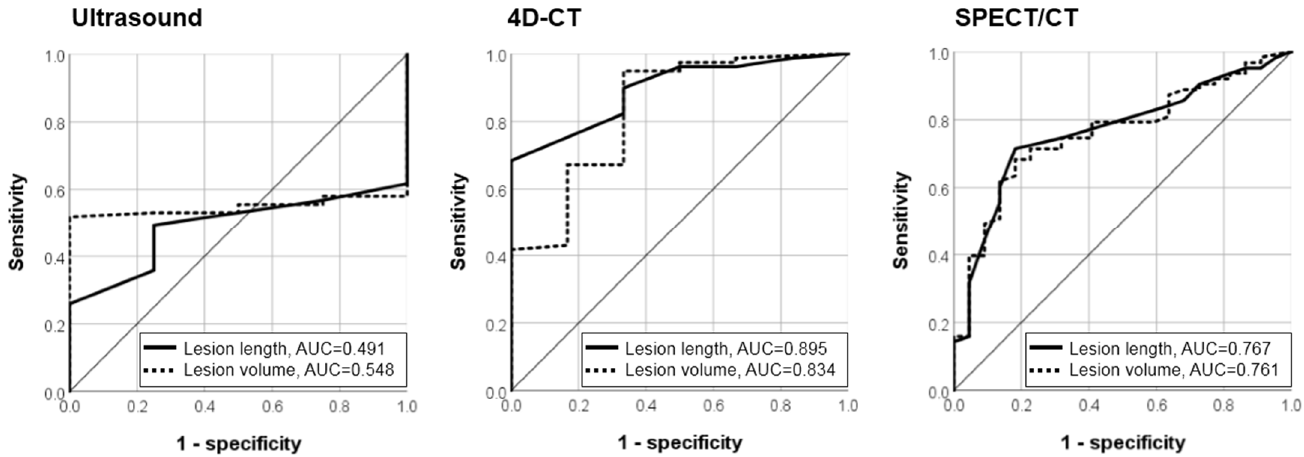
Figure 2. The ROC curves of lesion length and lesion volume used for predicting image positive. [Ultrasound] AUC of lesion length and lesion volume used for predicting image positive on ultra- sound were 0.491 ( p = 0.950, 95% confidence interval [CI], 0.345–0.637) and 0.548 ( p = 0.748, 95% CI, 0.439–0.656). [4D-CT] AUC of lesion length and lesion volume used for predicting image positive on 4D-CT were 0.895 ( p = 0.001, 95% CI, 0.798–0.991) and 0.834 ( p = 0.007, 95% CI, 0.656–1.000). [SPECT/CT] AUC of lesion length and lesion volume used for predicting image positive on sestamibi SPECT/CT were 0.767 ( p < 0.001, 95% CI, 0.658–0.875) and 0.761 ( p < 0.001, 95%CI, 0.652–0.870). The Youden’s index indicated that the lesion length (1.15 cm as cut-off point, sensi- tivity 68.4%, specificity 1.00%) and lesion volume (0.118 cm 3 as cut-off point, sensitivity 94.9%, specificity 66.7%) were helpful to predict the image positivity on 4D-CT. The sen- sitivity of 4D-CT on lesions >1.15 cm was 100%, which decreased to 81.3% when the lesion length was ≤ 1.15 cm. The sensitivity of 4D-CT on lesions >0.118 cm 3 was 97.4%, which decreased to 50.0% when the lesion length was ≤ 0.118 cm 3 . The lesion length (1.25 cm as cut-off point, sensitivity 71.4%, specificity 81.8%) and lesion volume (0.398 cm 3 as cut-off point, sensitivity 68.3%, specificity 81.8%) were helpful to predict image positivity in ses- tamibi SPECT/CT. The sensitivity of sestamibi SPECT/CT on lesions >1.25 cm was 91.8%, which decreased to 50.0% when the lesion length was ≤ 1.25 cm. The sensitivity of sesta- mibi SPECT/CT on lesions >0.398 cm 3 was 91.5%, which decreased to 52.6% when the le- sion length was ≤ 0.398 cm 3 . 4. Discussion Our study reveals that ultrasound exhibited the highest sensitivity (0.953) and accu- racy (0.943) among the imaging modalities, while 4D-CT exhibited a higher sensitivity and accuracy than sestamibi SPECT/CT (sensitivity/accuracy, 4D-CT vs. sestamibi SPECT/CT: 0.929/0.920 vs. 0.741/0.716). Combined ultrasound with 4D-CT and the three combined modalities had equivalent, and the highest, diagnostic performance (sensitivity 1.000, accuracy 0.989). Similar results were also observed in the SHPT lesions. In the PHPT lesions, the sensitivity and accuracy of ultrasound, 4D-CT, and the three combined mo- dalities were equivalent (1.000 and 0.889), and higher than the sensitivity and accuracy of sestamibi SPECT/CT (0.625 and 0.556). The lesion length and volume were important pre- dictors of the diagnostic performance of 4D-CT and sestamibi SPECT/CT (AUC of length in 4D-CT/volume in 4D-CT/length in sestamibi SPECT/volume in sestamibi SPECT: 0.895/0.834/0.767/0.761). With a lesion length ≤ 1.15 cm or lesion volume ≤ 0.118 cm 3 , the sensitivity of 4D-CT significantly decreased. With a lesion length ≤ 1.25 cm or lesion vol- ume ≤ 0.398 cm 3 , the sensitivity of sestamibi SPECT/CT significantly decreased. The accuracy of ultrasound may be difficult to generalize as it depends on the exper- tise of the operator. A previous meta-analysis study revealed that the sensitivity and pos- itive predictive values of ultrasound, sestamibi SPECT, and 4D-CT were 76.1% and 93.2%,